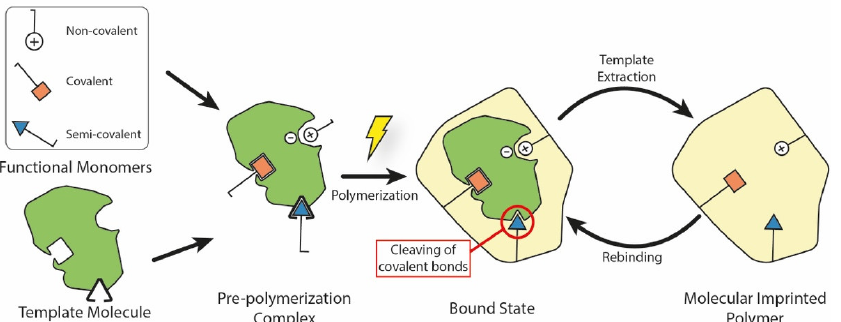
Figure 1. Main elements and fabrication steps to produce a molecularly imprinted polymer. During the pre-polymerization step, different chemical bonds may form between the template molecule and functional monomers. In the semi-covalent case, covalent bonds are cleaved after polymerization, leaving accessible binding sites inside the MIP. During the rebinding step, the template interacts with these sites using non-covalent interactions.